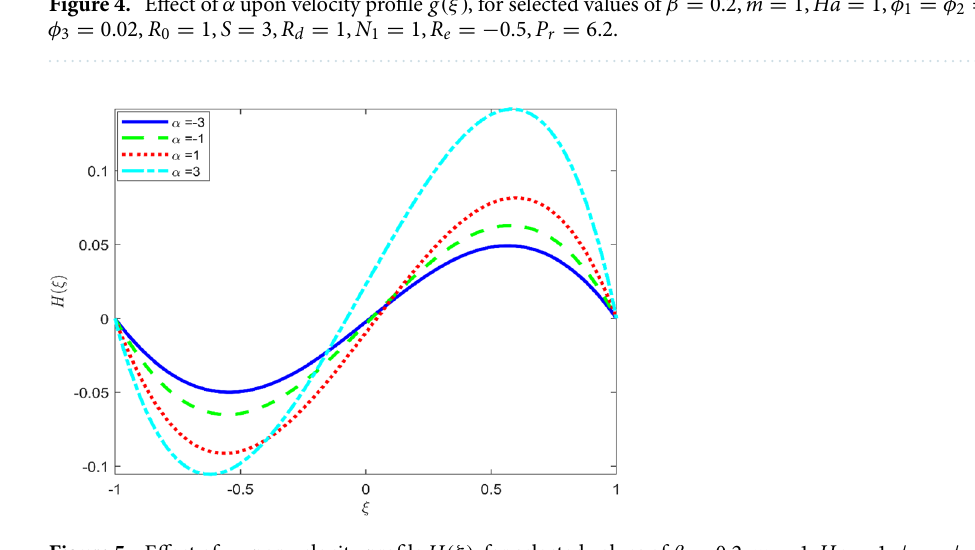
Figure 5. Effect of α upon velocity profile H (ξ) , for selected values of β = 0.2, m = 1, Ha = 1, φ 1 = φ 2 = φ 3 = 0.02 , R 0